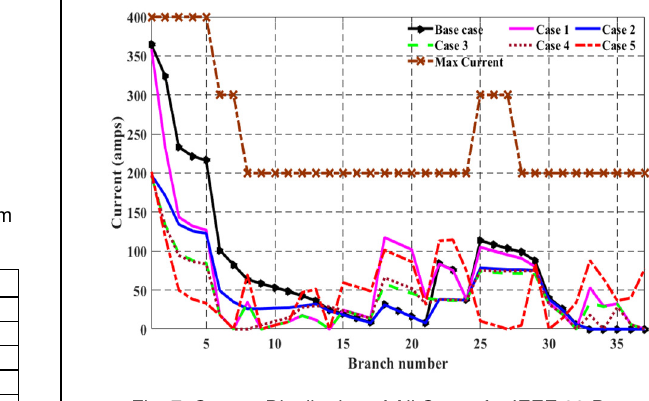
Fig. 7: Current Distribution of All Cases for IEEE